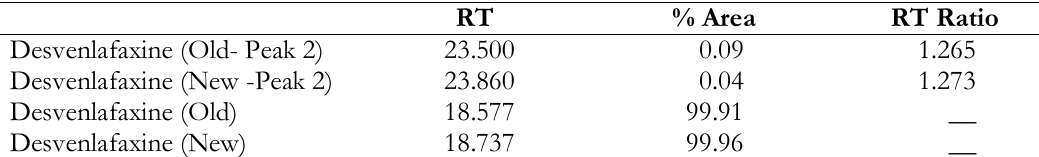
Table III. Chromatographic measurements of old and new polymorph of